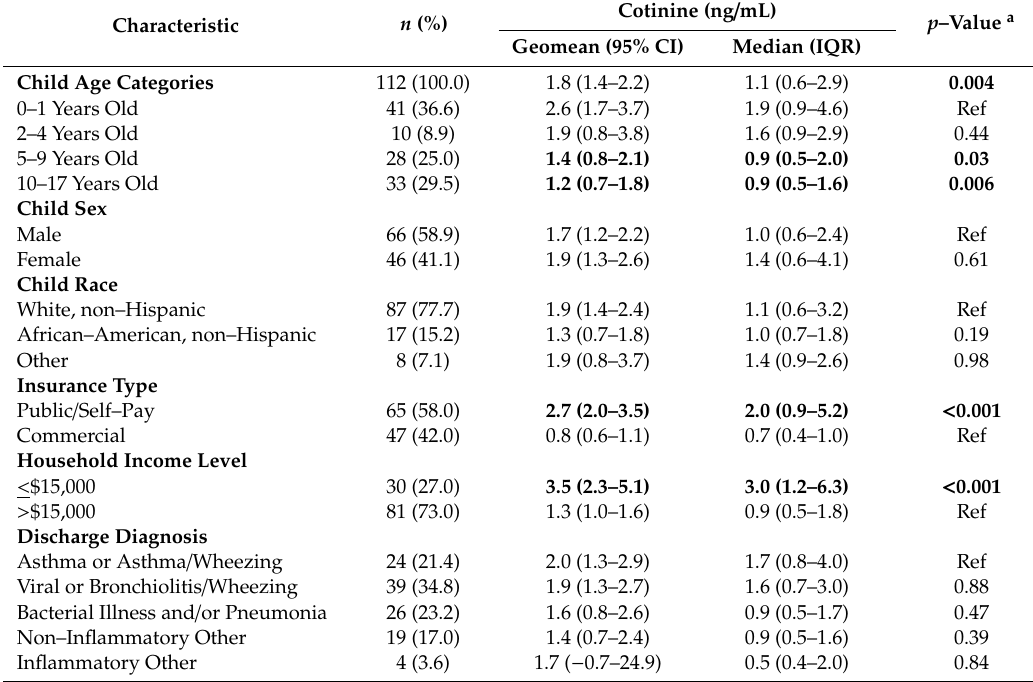
Table 1. Patient characteristics by log-cotinine